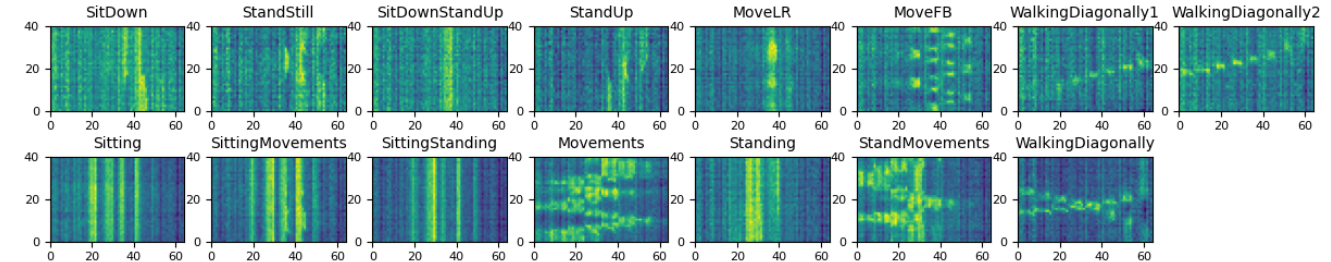
Figure 5. Illustration of the 2D spatiotemporal maps for the single-subject activities ( first row ) and double-subject activities ( second row ) of the Coventry-2018 dataset.